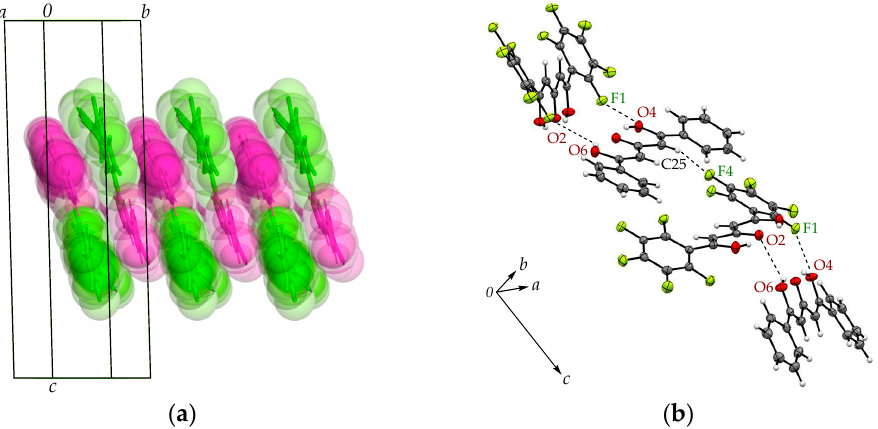
Figure 5. Packing structure of H 2 2 • H 2 4 : ( a ) the comprehensive view of the stacking structure and ( b ) major intermolecular interactions.